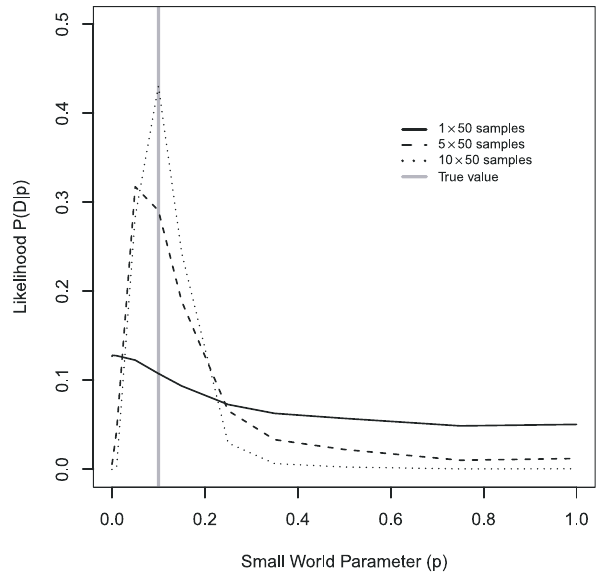
Figure 2. Likelihood of the small world parameter p , for increasing numbers of independent samples from networks with true small world parameter p ~ 0 : 1 .